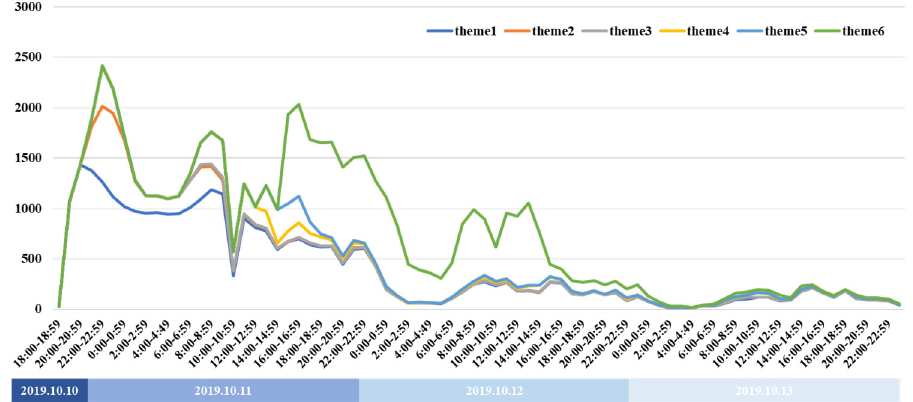
Figure 8. Trends for the six themes for the number of messages related to accident.